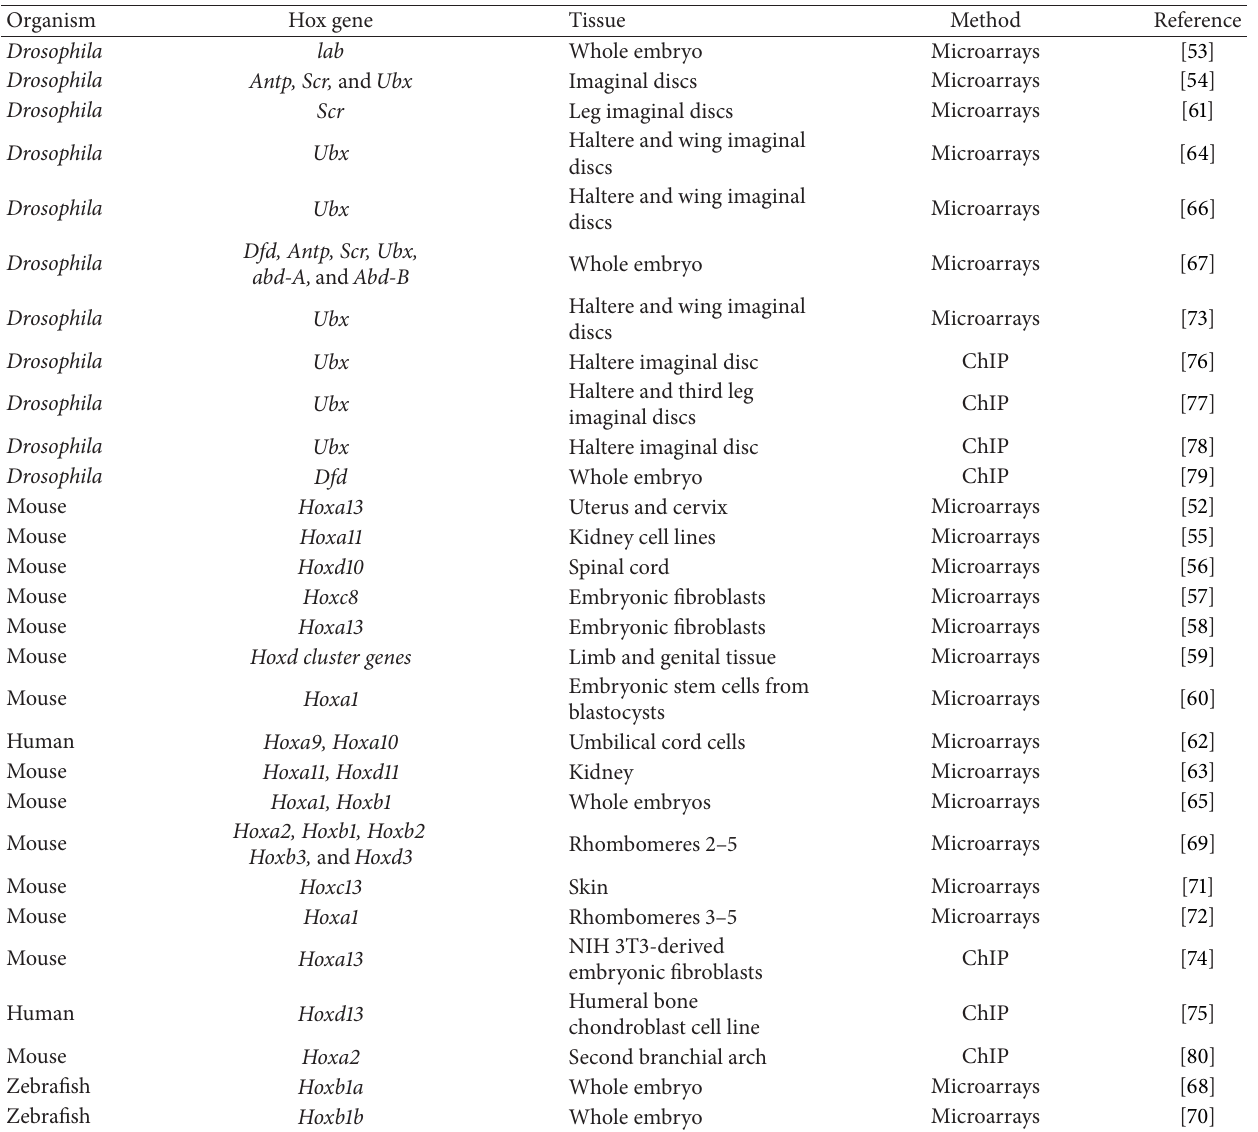
Table 1: Microarray expression profile and ChIP methods used to identify Hox targets. The Hox genes are studied in the wildtype, in Hox mutants, or after Hox ectopic expression. Modified from